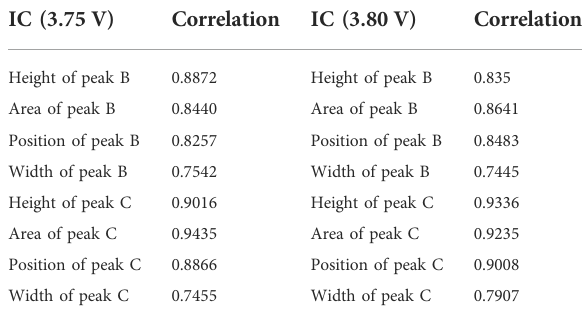
TABLE1Correlationbetweencapacityandpotentialhealthindicators. IC (3.75